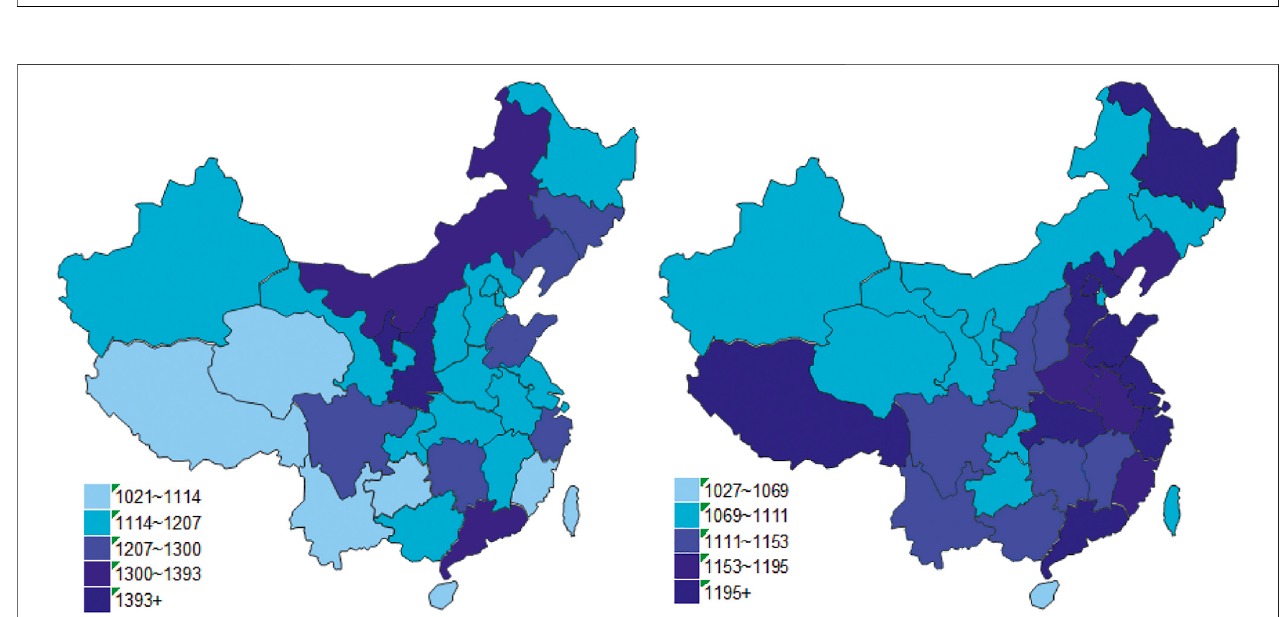
FIGURE 3 | Top 5 and last 3 provinces by the Baidu index of yoga in 2020.